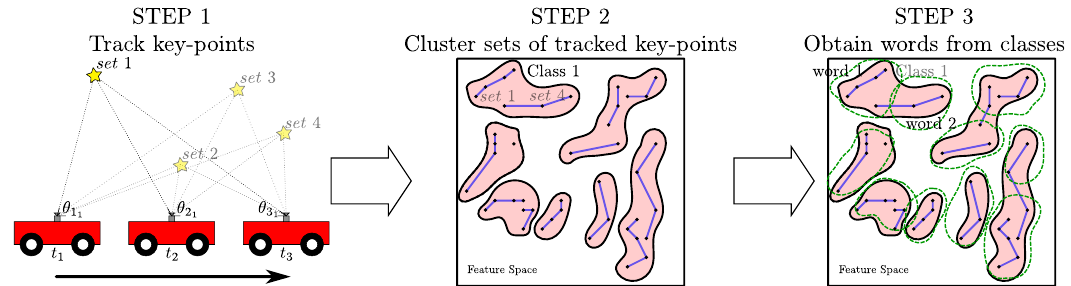
Figure 1. Diagram of our novel vocabulary construction method. During the acquisition, extracted image key-points are tracked. All the image appearances and altitude angle values of these key-points are stored and grouped together under the same set number. These sets of tracked key-points are later clustered into classes, with the elements in each class representing the same element of the